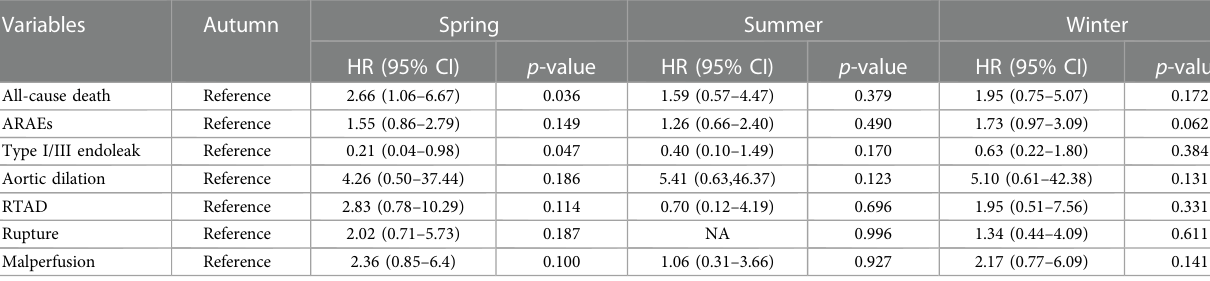
TABLE 4 Cox analyses of 1-year mortality and ARAEs strati fi ed with seasons of TEVAR. Variables Autumn